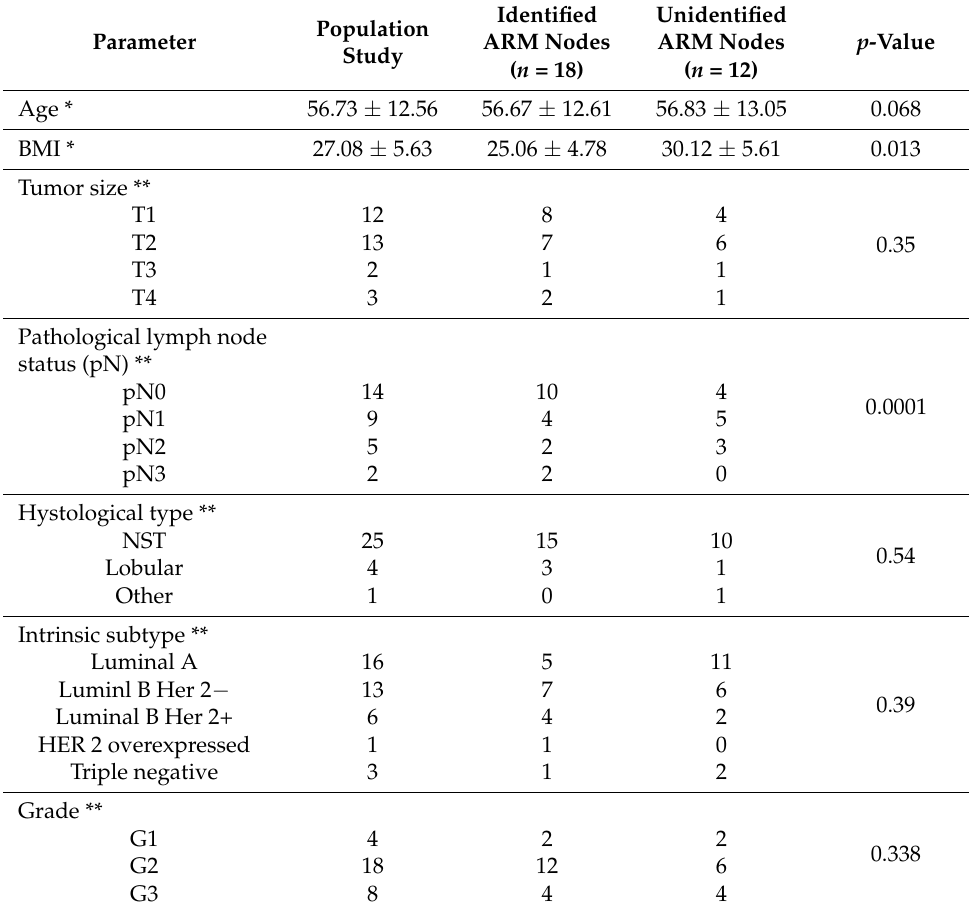
Table 1. Population study and factors that might influence ARM node